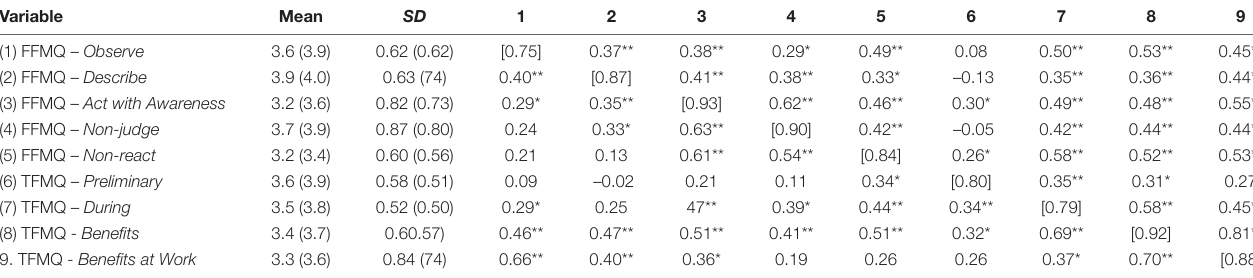
TABLE 2 | Descriptive statistics, correlations, and Cronbach’s alphas. Variable